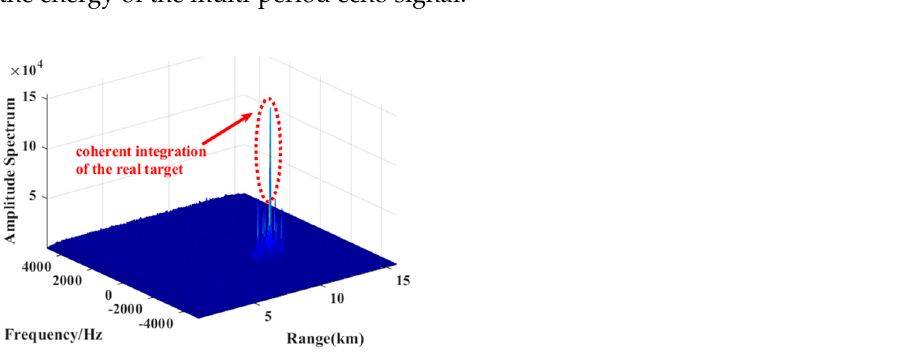
Figure 13. Pulse compression result of multi-period echo signal after compensating based on the improved Keystone algorithm.